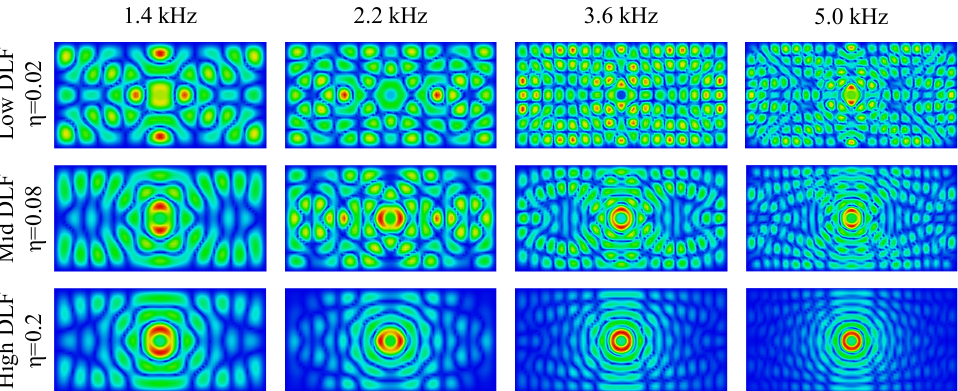
Figure 9. Simulated frequency-dependent surface displacement scaled according to the individual maximum value of a panel with different damping loss factors applied. With increased damping, the traveling wave pattern becomes